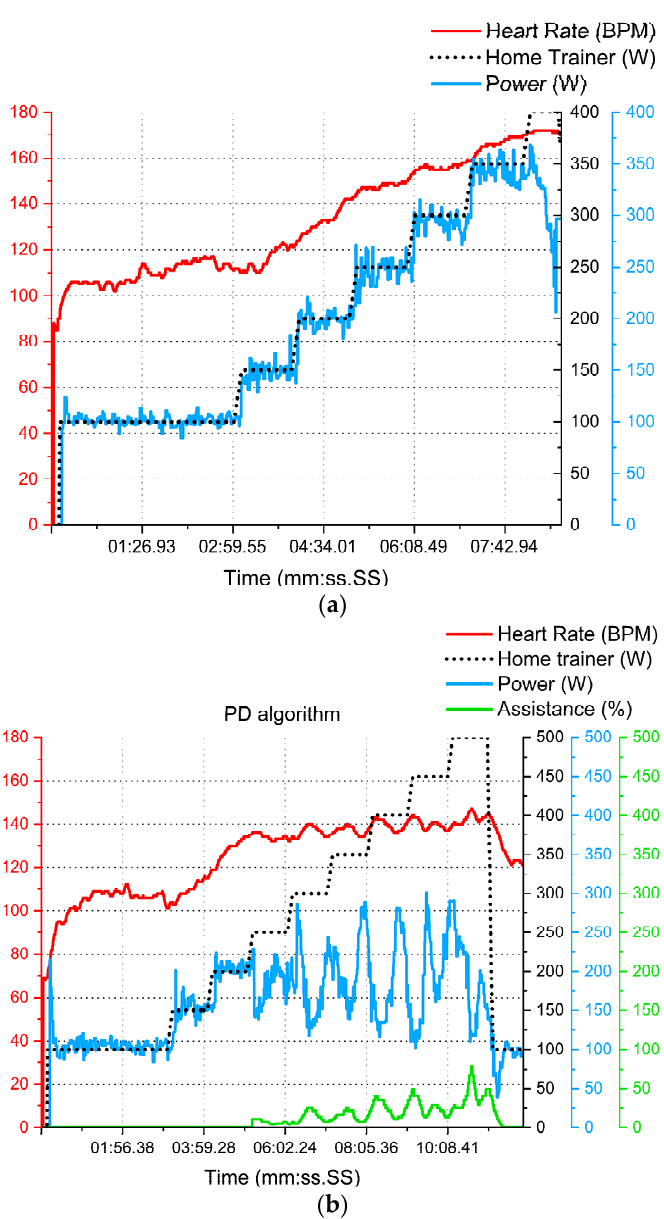
Figure 10. Example (N = 1) of test results with no electrical assistance ( a ) vs. PD algorithm ( b ) outcomes.